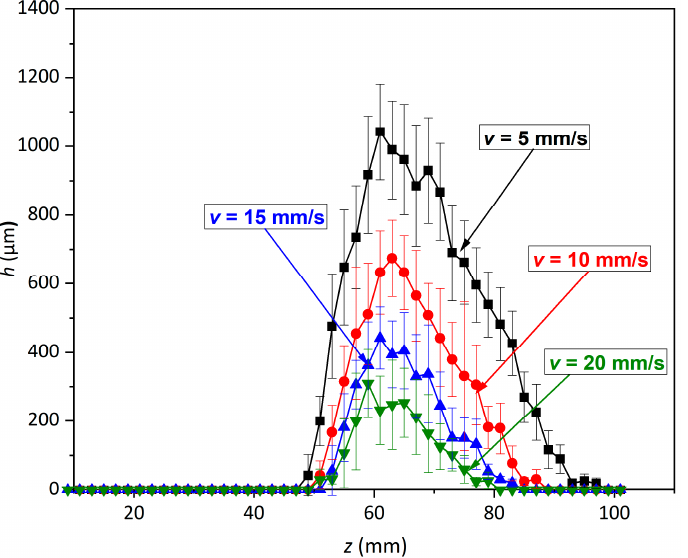
Figure 3. Erosion depth variation with standoff distance z (5–101 mm) and nozzle traverse speed v (5 (4000 impacts/mm) to 20 mm/s (1000 impacts/mm)).